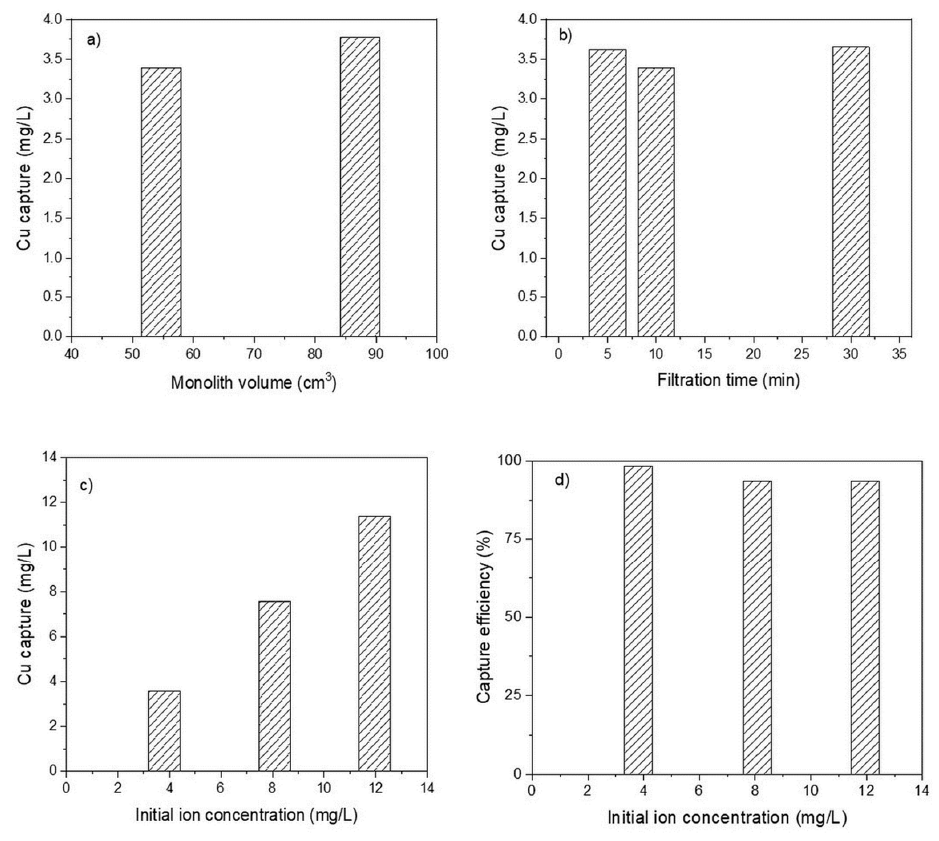
Figure 6. Effect of the operating parameters: ( a ) monolith volume, ( b ) filtration time, and ( c , d ) initial ion concentration.